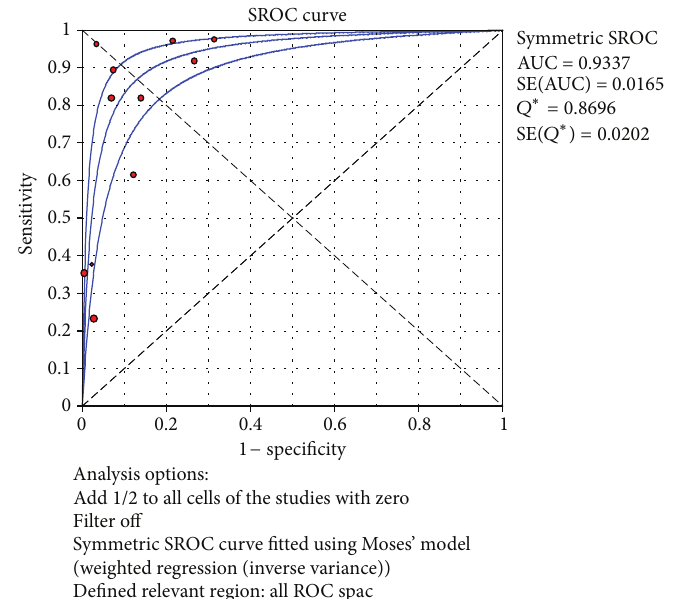
Figure 7: Summary receiver operating characteristic (SROC) curve of the TNF- 𝛼 test for the diagnosis of late-onset neonatal sepsis. Each point represents one study in the SROC